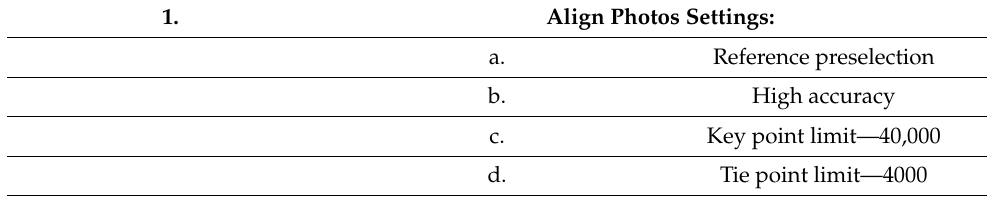
Table 3. Agisoft Metashape settings used to process the UAV imagery into orthophoto and DSM